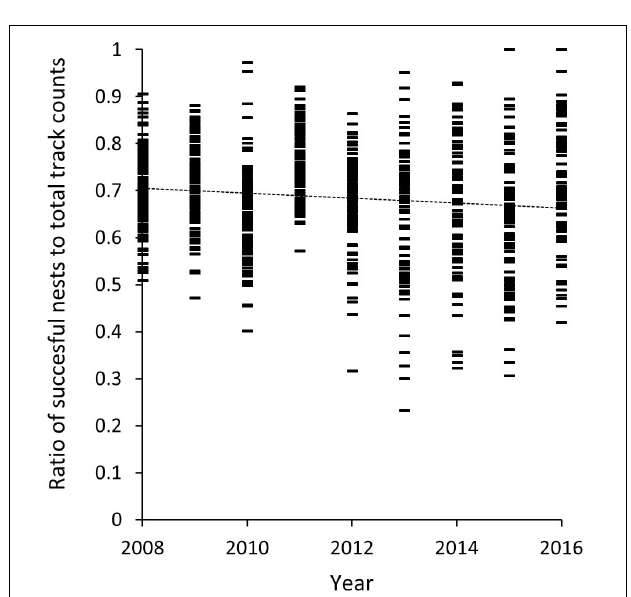
FIGURE 8 | Ratio of mean daily nesting success of track count data for beaches included in the 9-km long-term trend analysis (K5–K13) for Masirah loggerheads